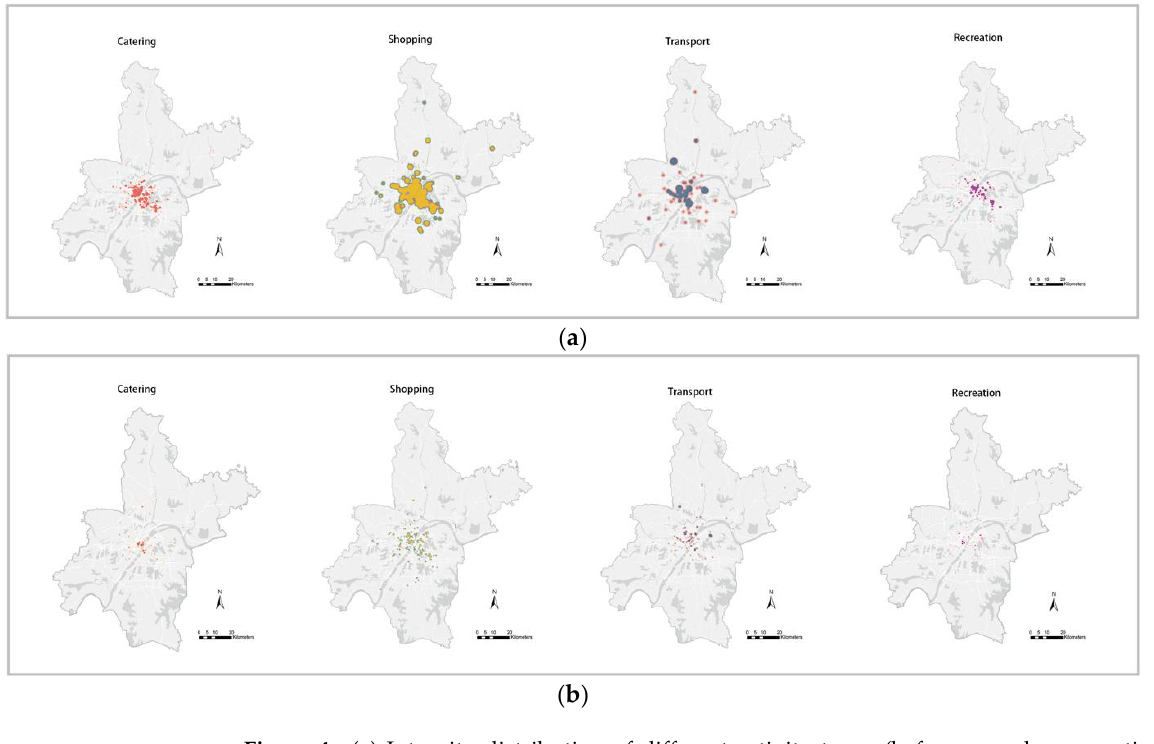
Figure 4. ( a ) Intensity distribution of different activity types (before non-pharmaceutical interventions on COVID-19 in Wuhan). ( b ) Intensity distribution of different activity types (after non-pharmaceutical interventions).